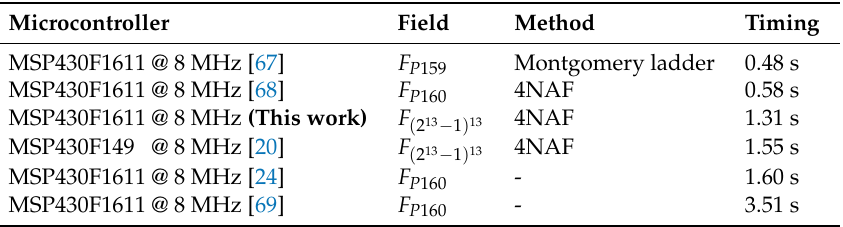
Table 2. Timings for ECC random point